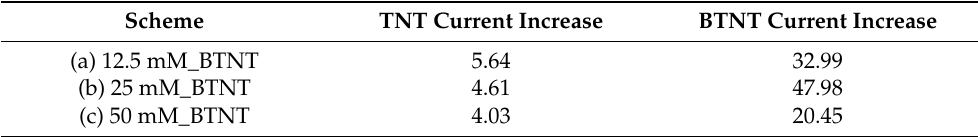
Table 3. Photo-oxidation current density increase for unmodified and modified TNT